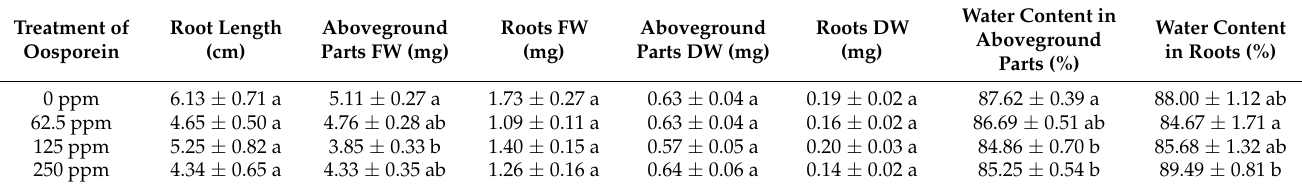
Table 4. Seedling growth of Miscanthus sinensis in growth inhibition test by